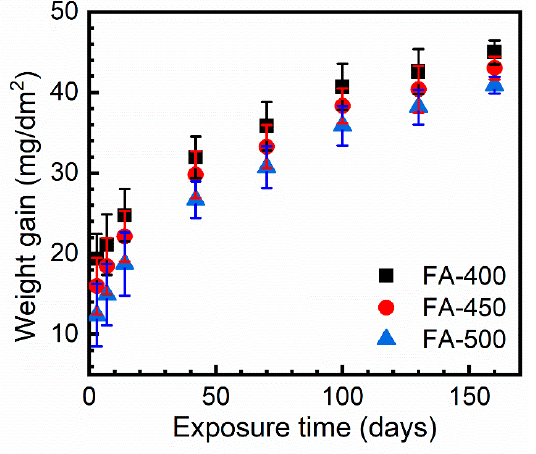
Figure 5. Weight gain versus exposure time for all samples.